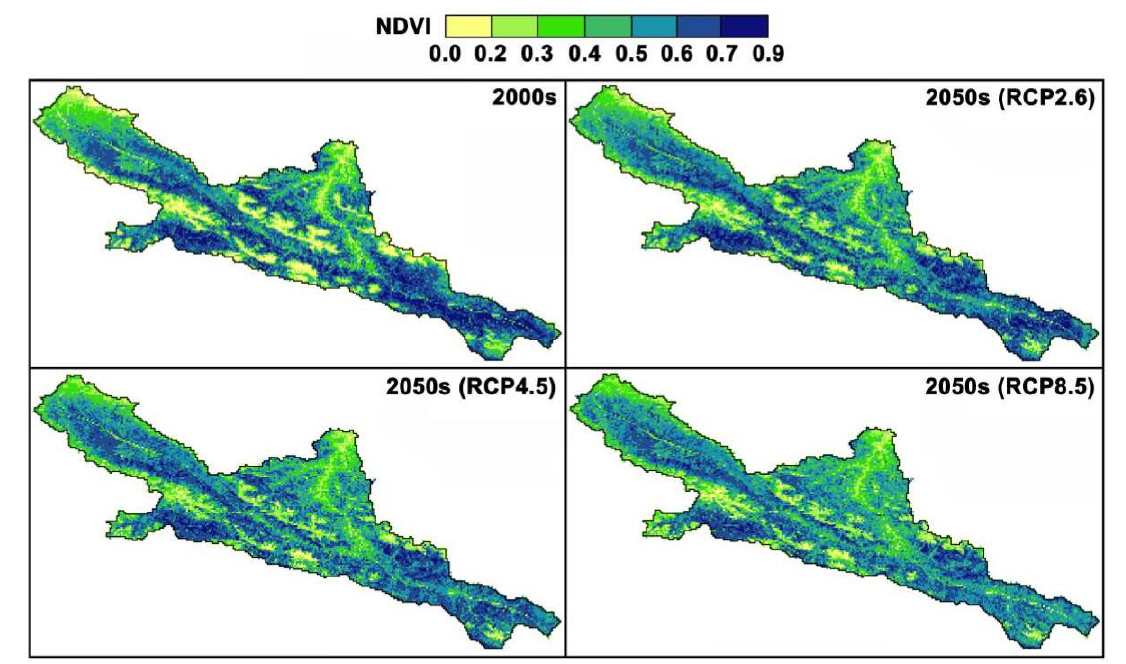
Figure 6. Distribution of vegetation type for the 2000s and the 2050s under the RCP2.6, RCP4.5 and RCP8.5 scenarios in the study area.